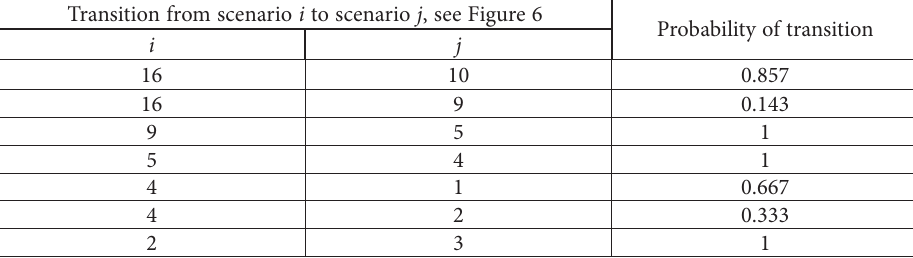
Table 4. Probabilities of transitions evaluated by the heuristic (11) – total ignorance case Transition from scenario i to scenario j , see Figure 6